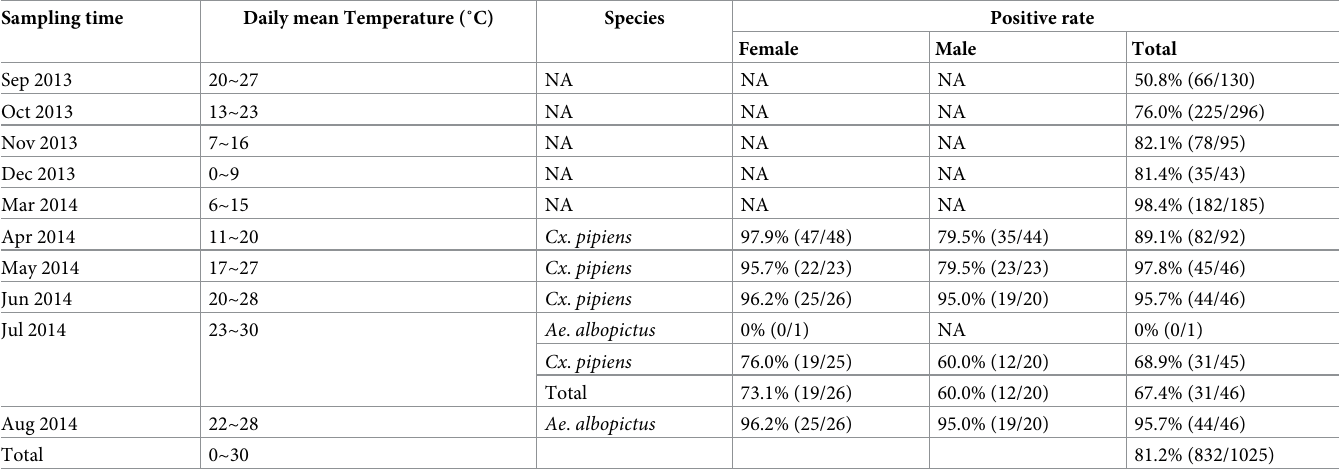
Table 3. The presence and positive rates of Wolbachia in mosquitoes collected in Yangzhou, Jiangsu province between September 2013 and August 2014. Sampling